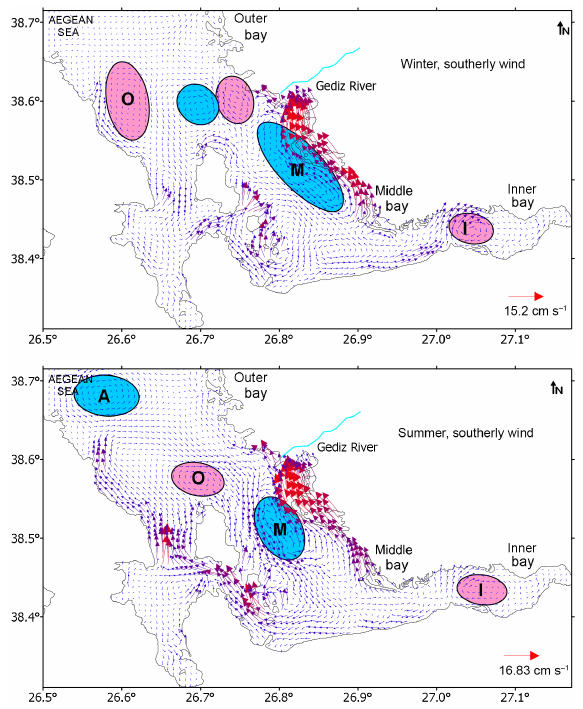
Figure 8. The barotropic current pattern (depth averaged) in the case of a southerly wind in winter and in summer.